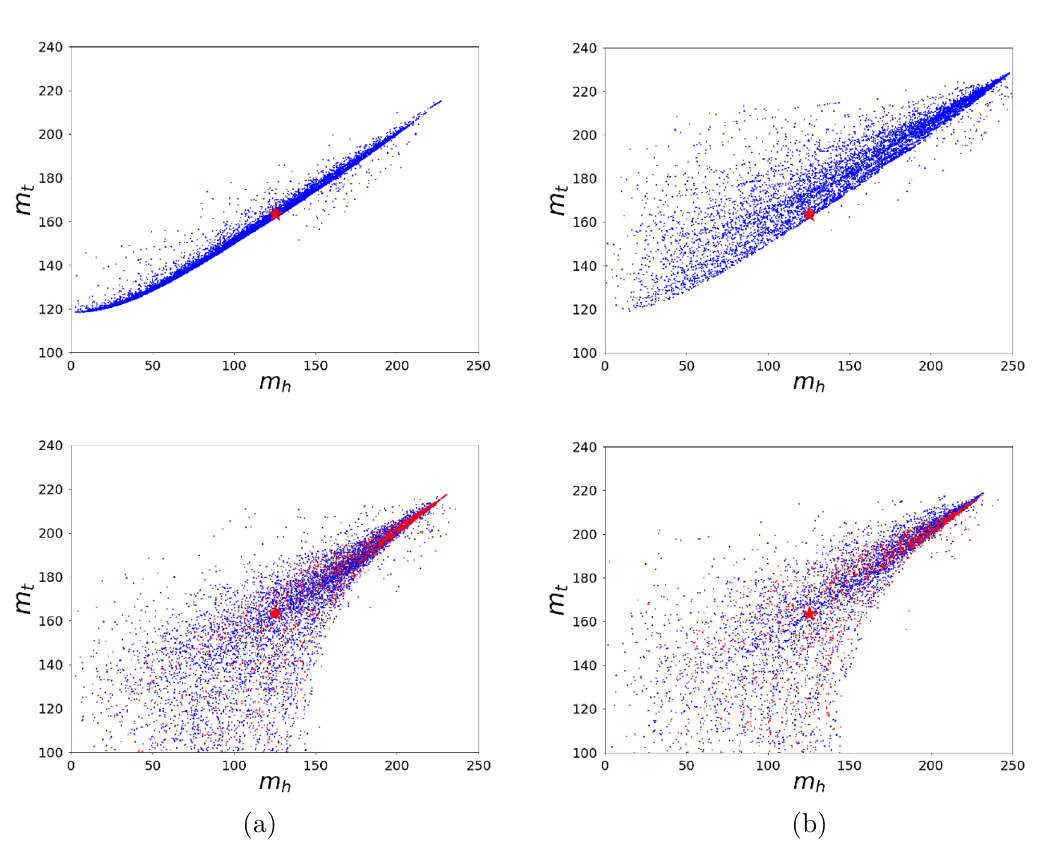
Figure 1 . Results of the parameter scans in the ( m h ; m t ) plane in cases (a) j k j < 1 and (b) j k j = 1 for (cid:3) = 10 18 GeV. The two upper plots are obtained in the case of a spherical vacuum, and the lower ones in the case of a disk/circle-shaped vacuum. For the points shown in red, the scalar potential is bounded from below at all energy scales between M Z and (cid:3). The red stars indicate the position of ( m h ; m MS ) (cid:25) (125 GeV ; 163 t